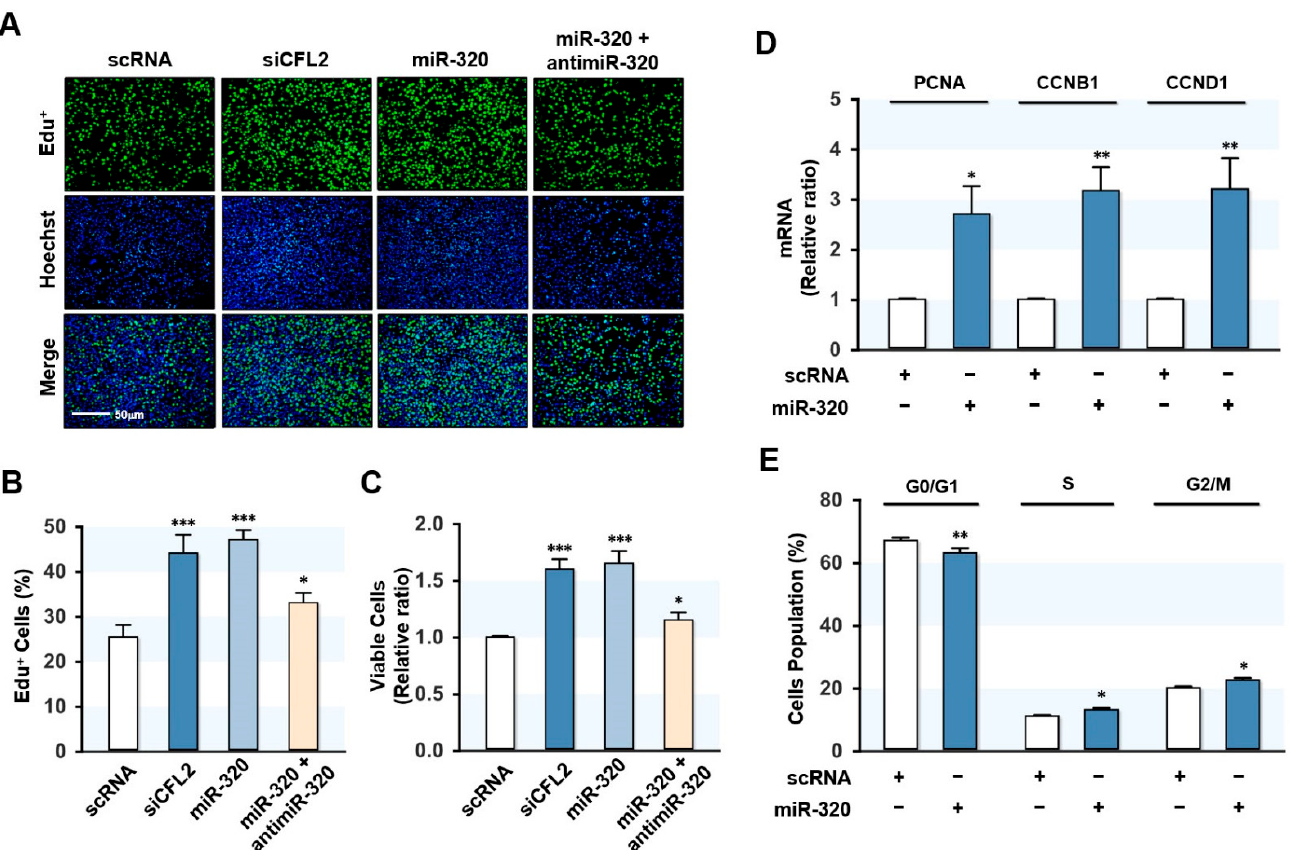
Figure 4. MiR-320-3p promoted cell proliferation and cell cycle progression. C2C12 cells were transfected with scRNA, CFL2 siRNA (siCFL2), miR-320-3p mimic (miR-320), or antimiR-320-3p (antimiR-320) for 24 h. ( A ) Representative images of EdU incorporation analysis. Cells during DNA replication were labeled with EdU (green), and nuclei were stained with Hoechst 33342 (blue). Scale bar, 50 µ m. ( B ) The percentage of EdU-positive cells was quantitated with ImageJ software. ( C ) Viable cells were stained and analyzed using a cell viability assay kit. ( D ) The mRNA level of YAP1 target genes, such as CCNB1, CCND1, and PCNA, was analyzed by q RT-PCR, and the values normalized against U6. ( E ) Flow cytometry analysis at 24 h after transfection. Results are means ± SEMs ( n > 3). *, p < 0.05; **, p < 0.01; ***, p < 0.001 vs. scRNA control.